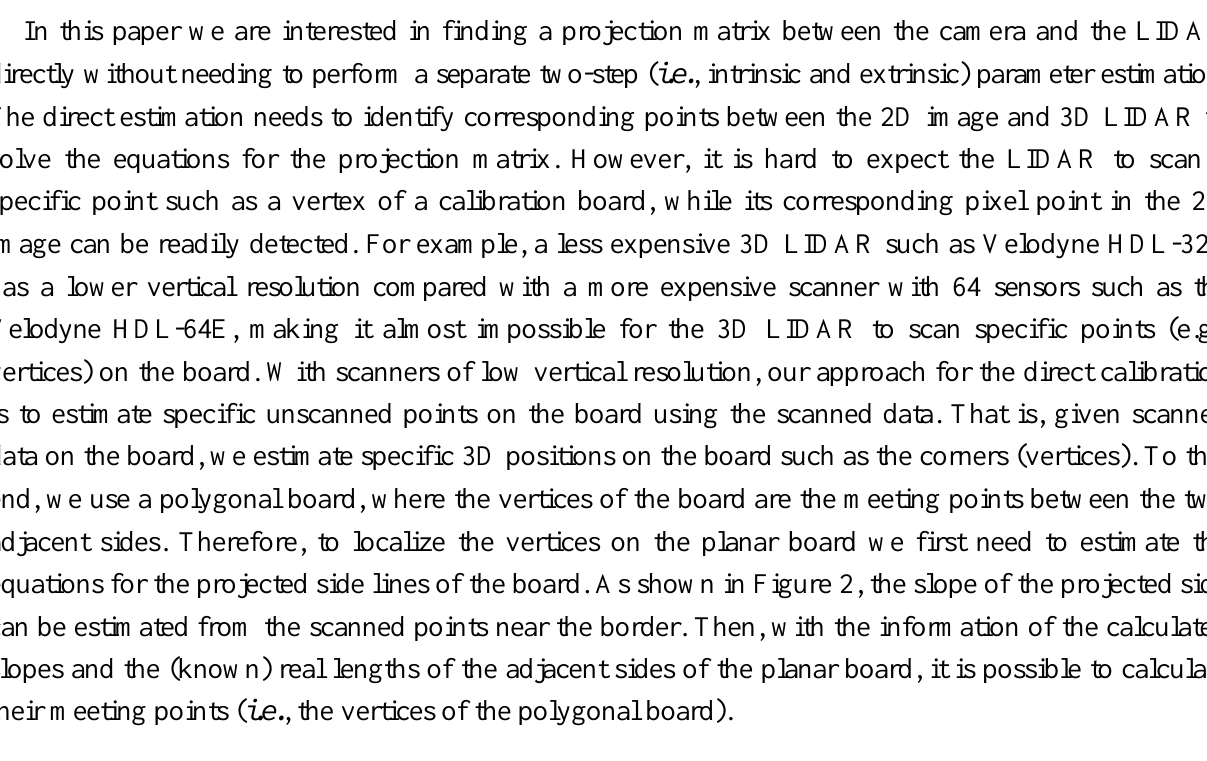
Figure 2. Calibration board with adjacent sides: the scanned points on the border of the plane are used for estimating the side lines of the